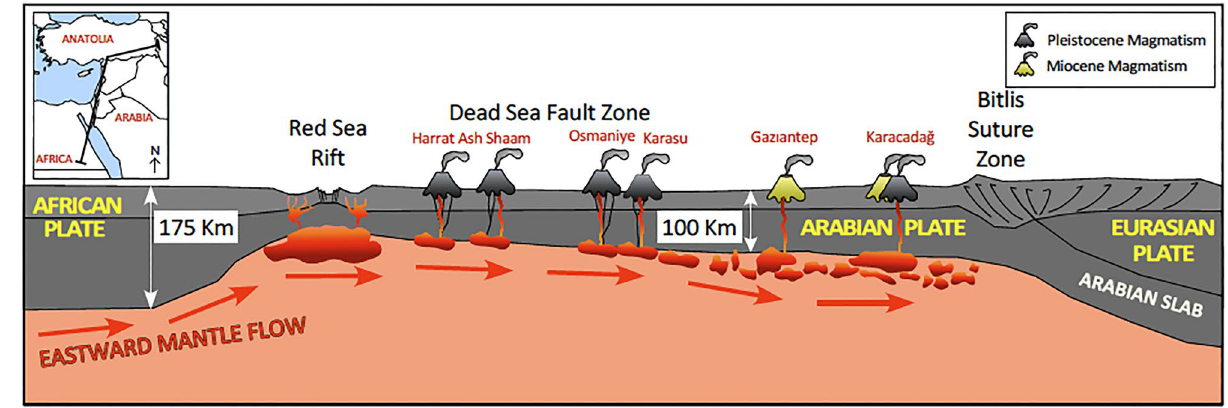
Figure 7. Schematic cross-section cartoon of the region. Major tectonic features and lithosphere/asthenosphere boundary are shown from the Red Sea Rift and the Dead Sea Fault Zone, throughout the Arabian foreland and until the Eurasian-Arabian convergent zone. Hot, buoyant asthenospheric mantle migrates from the rift region towards to the east, locally acting as a source for alkali basaltic volcanism. Insert shows trace of